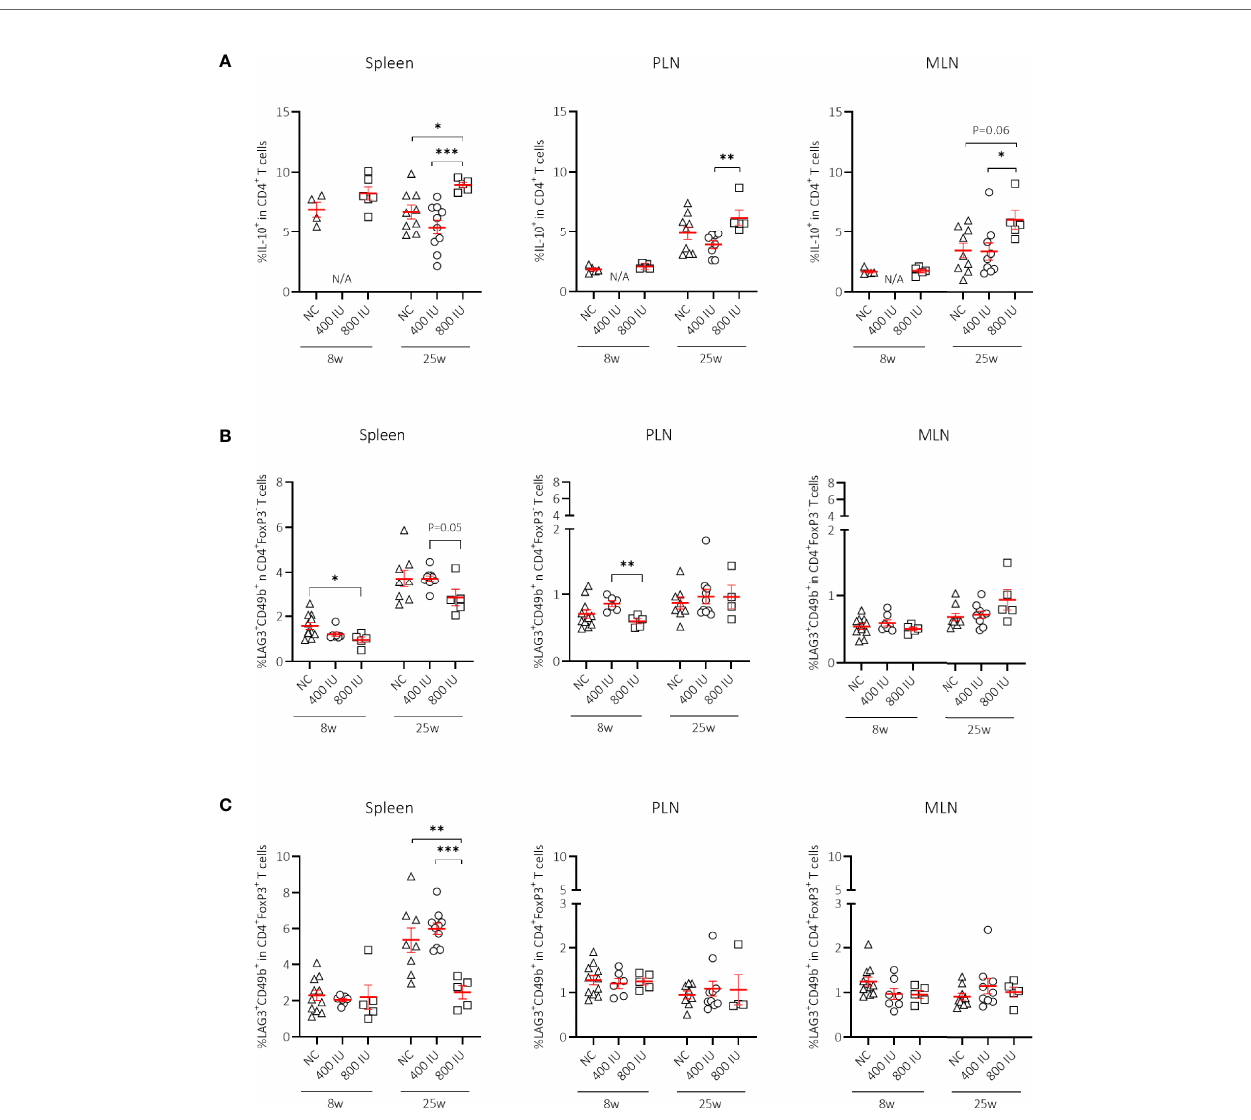
FIGURE 3 | Effect of vitamin D substitution regimen on frequency of IL-10-secreting CD4 + T cells. Frequency of IL-10-secreting CD4 + T cells within CD4 + T-cell gate (A) and frequency of Tr1 cells as de fi ned as LAG3 + CD49b + within the CD4 + FoxP3 – (B) , and CD4 + FoxP3 + T-cell gate (C) are shown at both 8 and 25 weeks of age in spleen, pancreatic draining lymph nodes (PLN), and mesenteric draining lymph nodes (MLN). Female NOD mice were fed normal chow (NC) or two different doses of vitamin D-supplemented (400 or 800 IU/day) diet from 3 until 25 weeks of age (lifelong). Symbols (N = 4-11) represent individual mice, and the line re fl ects the group mean with SEM. *P ≤ 0.05; **P ≤ 0.01; ***P ≤